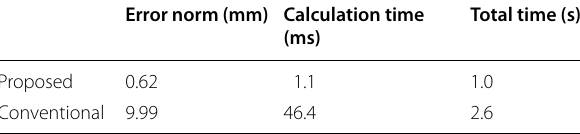
Table 2 Comparison of results in both methods Error norm (mm) Calculation time